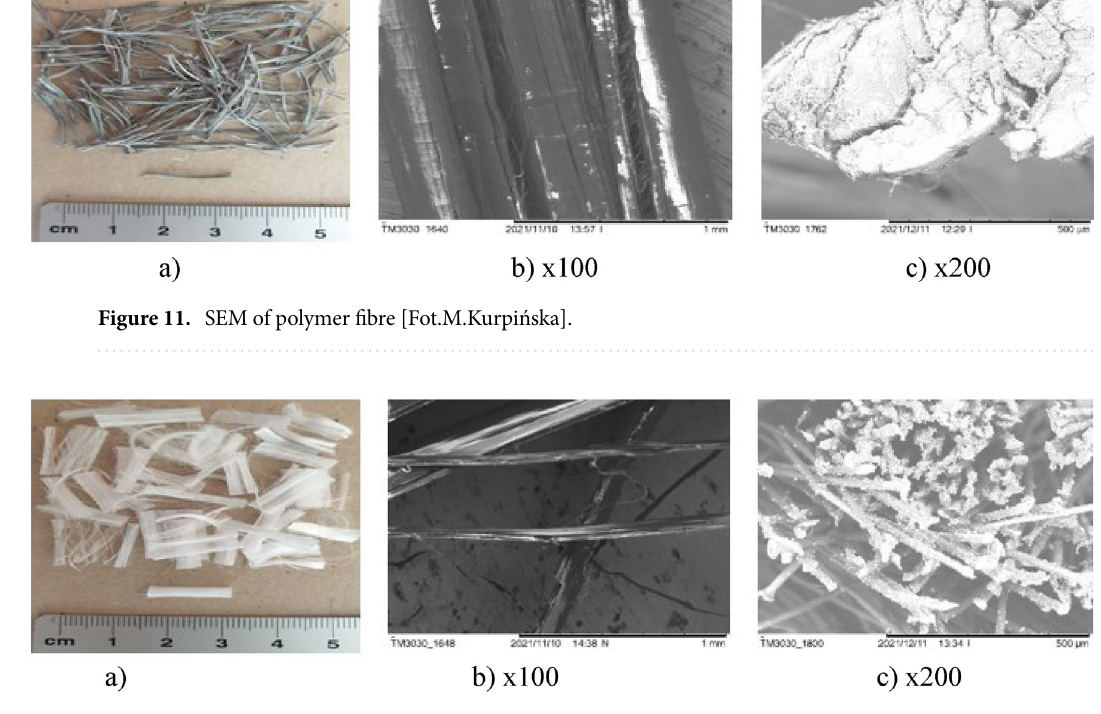
Figure 12. SEM of polypropylene (PP) fibre